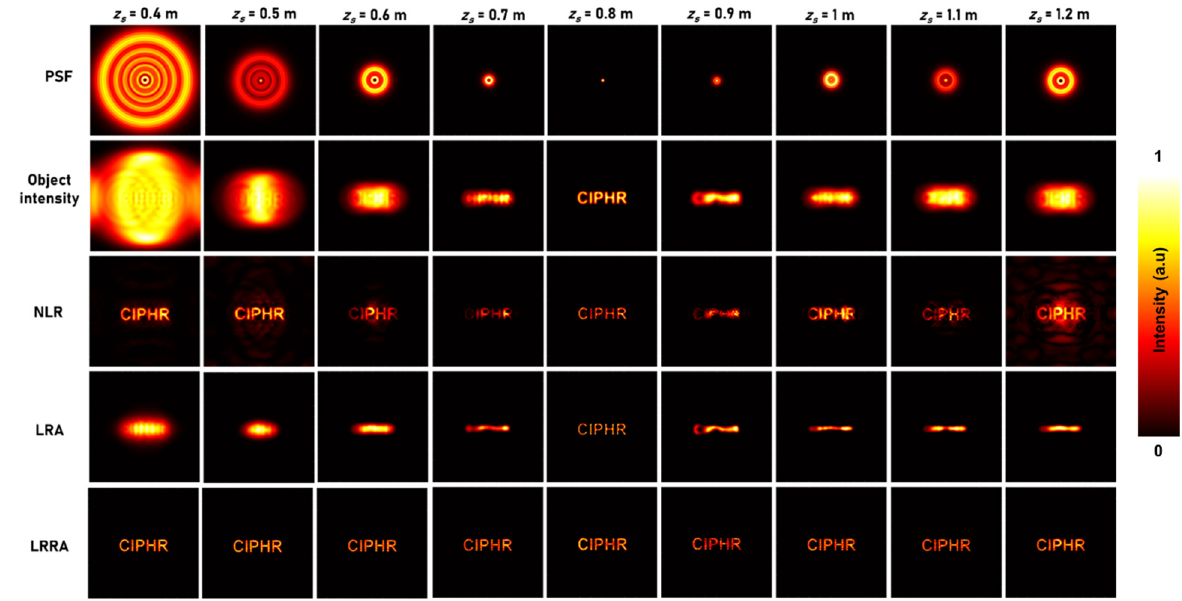
Figure 3. Simulation results of PSF, object intensity and reconstruction results using NLR, LRA and LRRA.